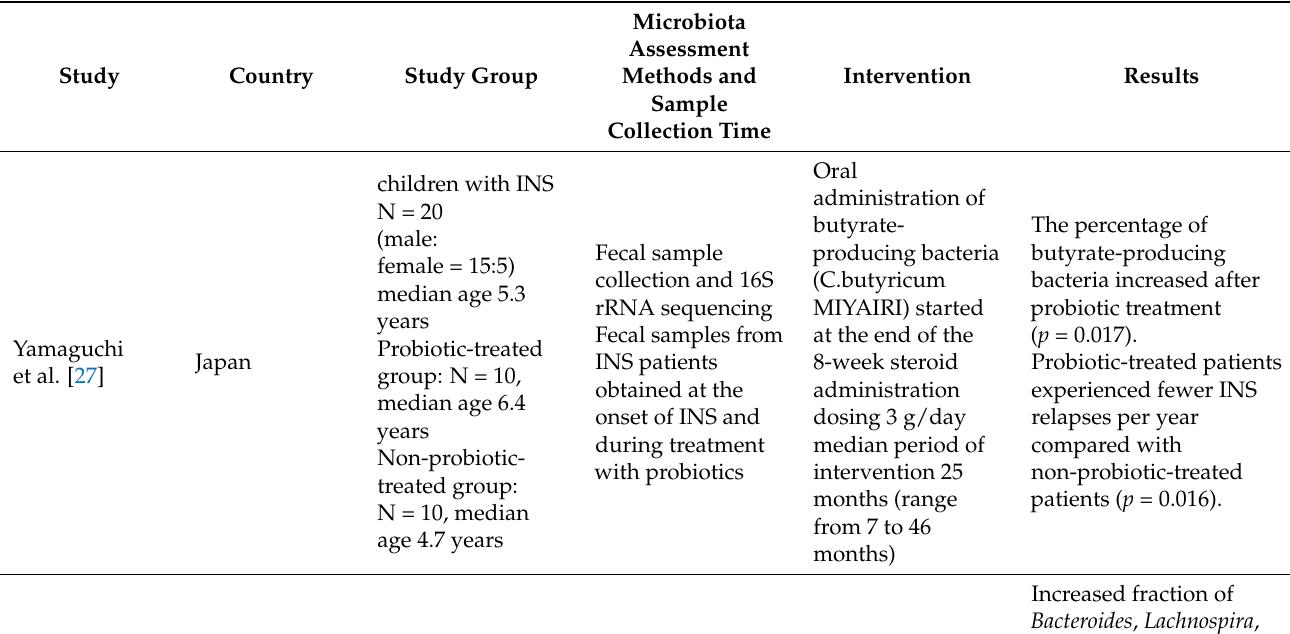
Table 3. The therapeutical gut microbiota modifications in children with idiopathic nephrotic syn- drome